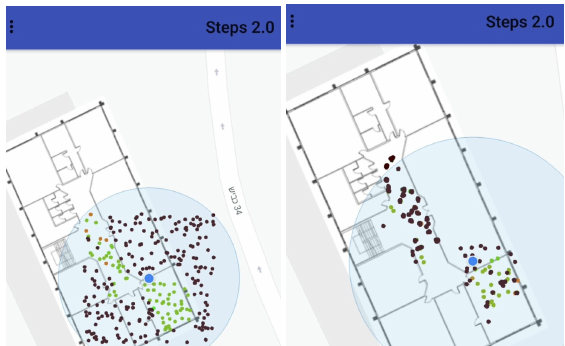
Figure 8. ( Left ): Particle initialization without indoor/outdoor sensing. ( Right ): The ability to classify between indoor and outdoor allows the algorithm to decrease the overall area of possible solution dramatically, leading to faster convergence with better